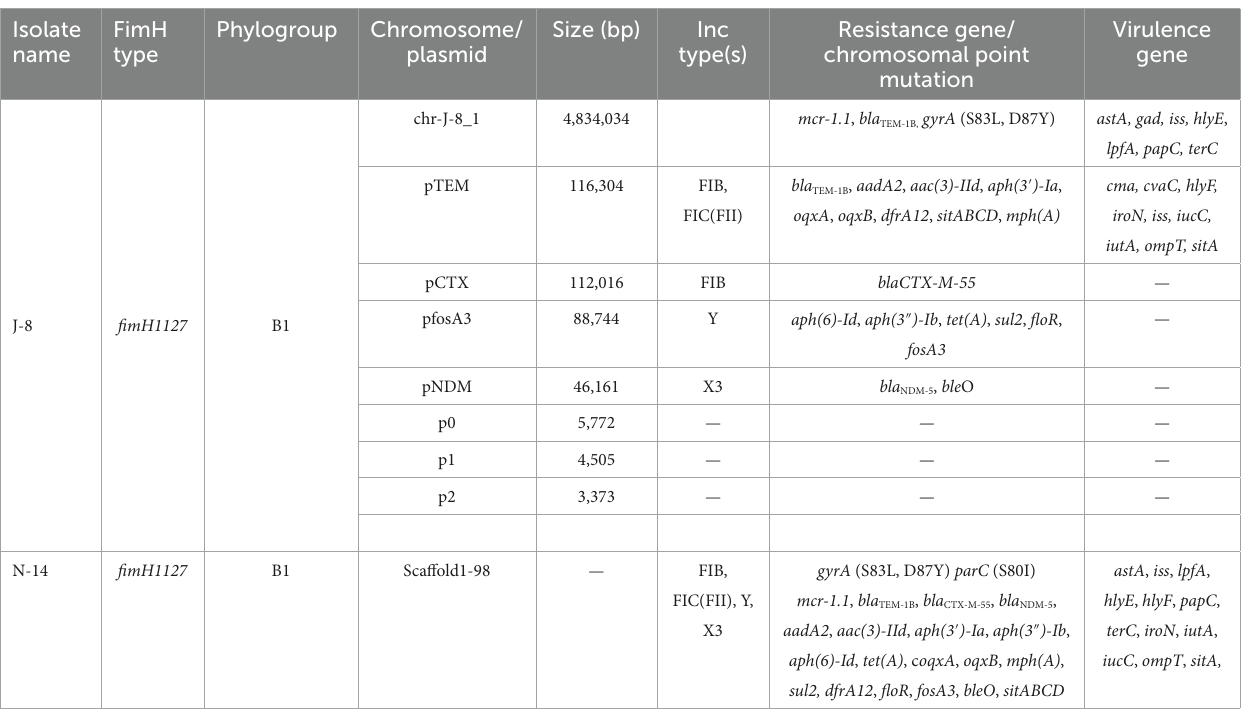
TABLE 3 Genomic features of two